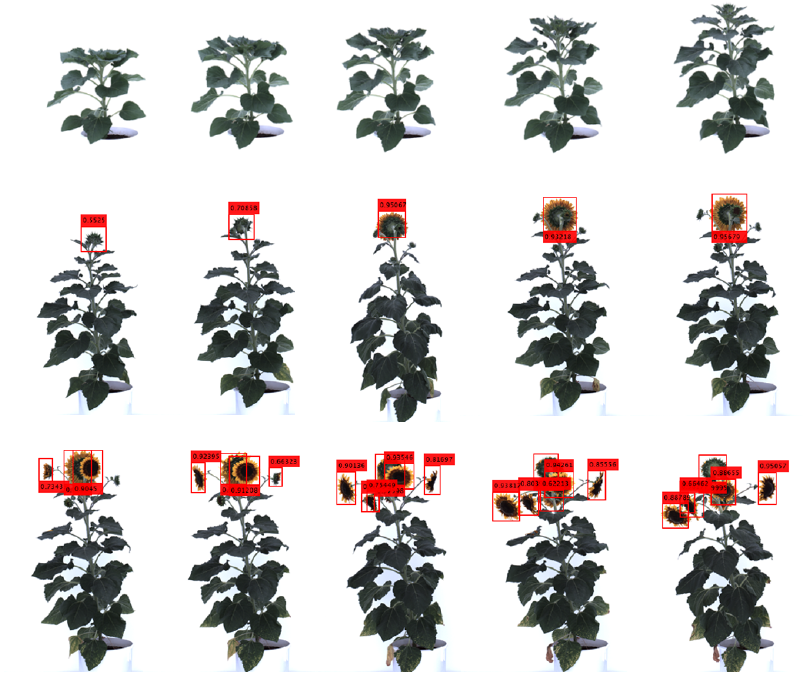
Figure 6. Illustration of flower emergence timing detection using a sample sunflower image sequence (D2) for the side view 0 ◦ over consecutive days (following left to right direction) starting from Day 10 ( top-left ) to Day 24 ( bottom-right ).